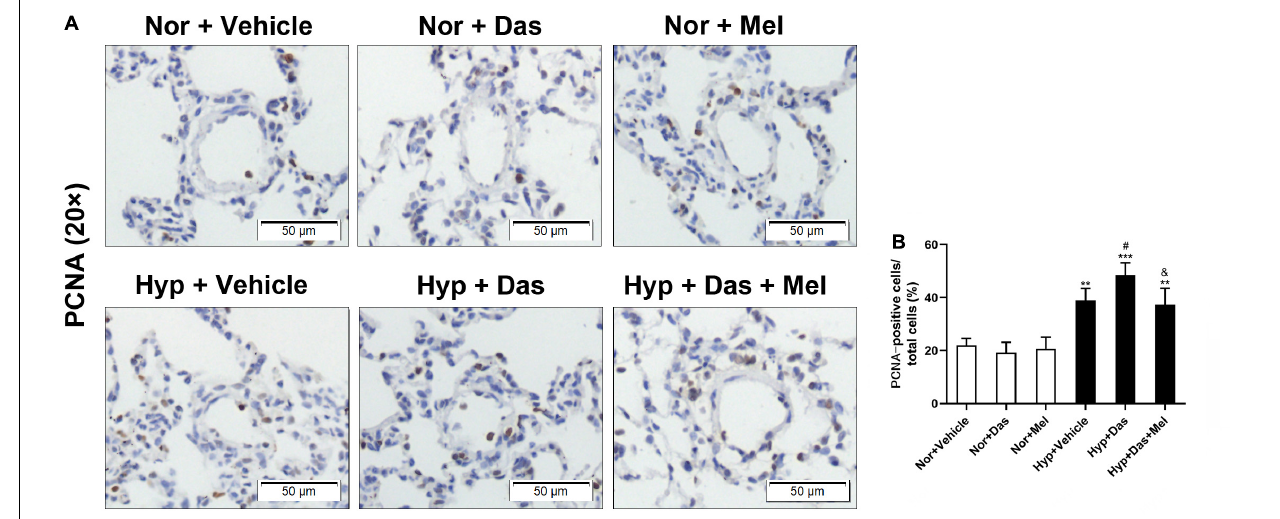
FIGURE 4 | PCNA staining of pulmonary arterioles (original magnification × 20, scale bars: 50 µ m) (A) , bar graph shows that the number of proliferating cell nuclear antigen (PCNA)-positive cells relative to the total smooth muscle cells in the medial wall of pulmonary arterioles (%) (B) . Values are means ± SEM, ***P < 0.001, **P < 0.01 compared with Nor + Vehicle group. # P < 0.05 compared with Hyp + Vehicle group. & P < 0.05 compared with Hyp + Das group ( n =